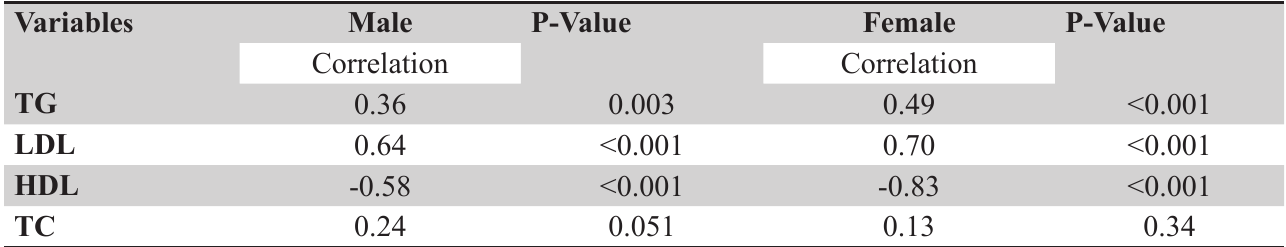
Table 6. Lipid profiles correlation between male and